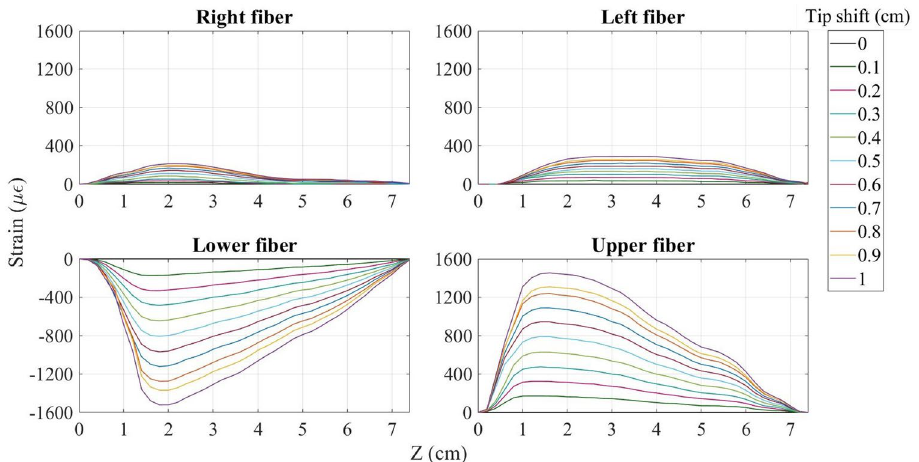
Figure 1. Strain detected by all four fibers over the length of the needle during its bending to the lower